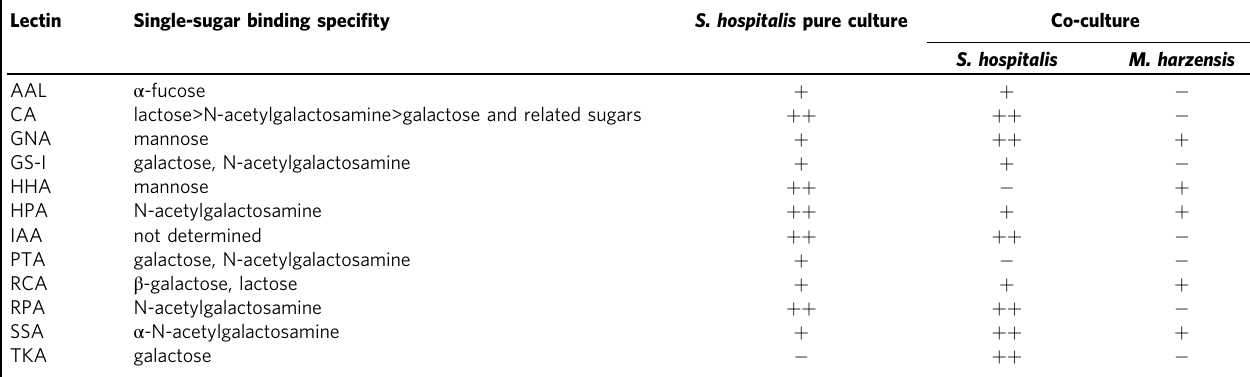
Table 1 Results of lectin staining of co-culture of Ca . Micrarchaeum harzensis and Ca . Schef fl eriplasma hospitalis and Ca . Schef fl eriplasma hospitalis pure culture. The table shows binding lectins, their abbreviation, carbohydrate-binding speci fi city and the strength of the signal in pure and co-culture (with + as weak binding, ++ as binding, and − as no binding). The experiment was repeated at least three times with equivalent results.